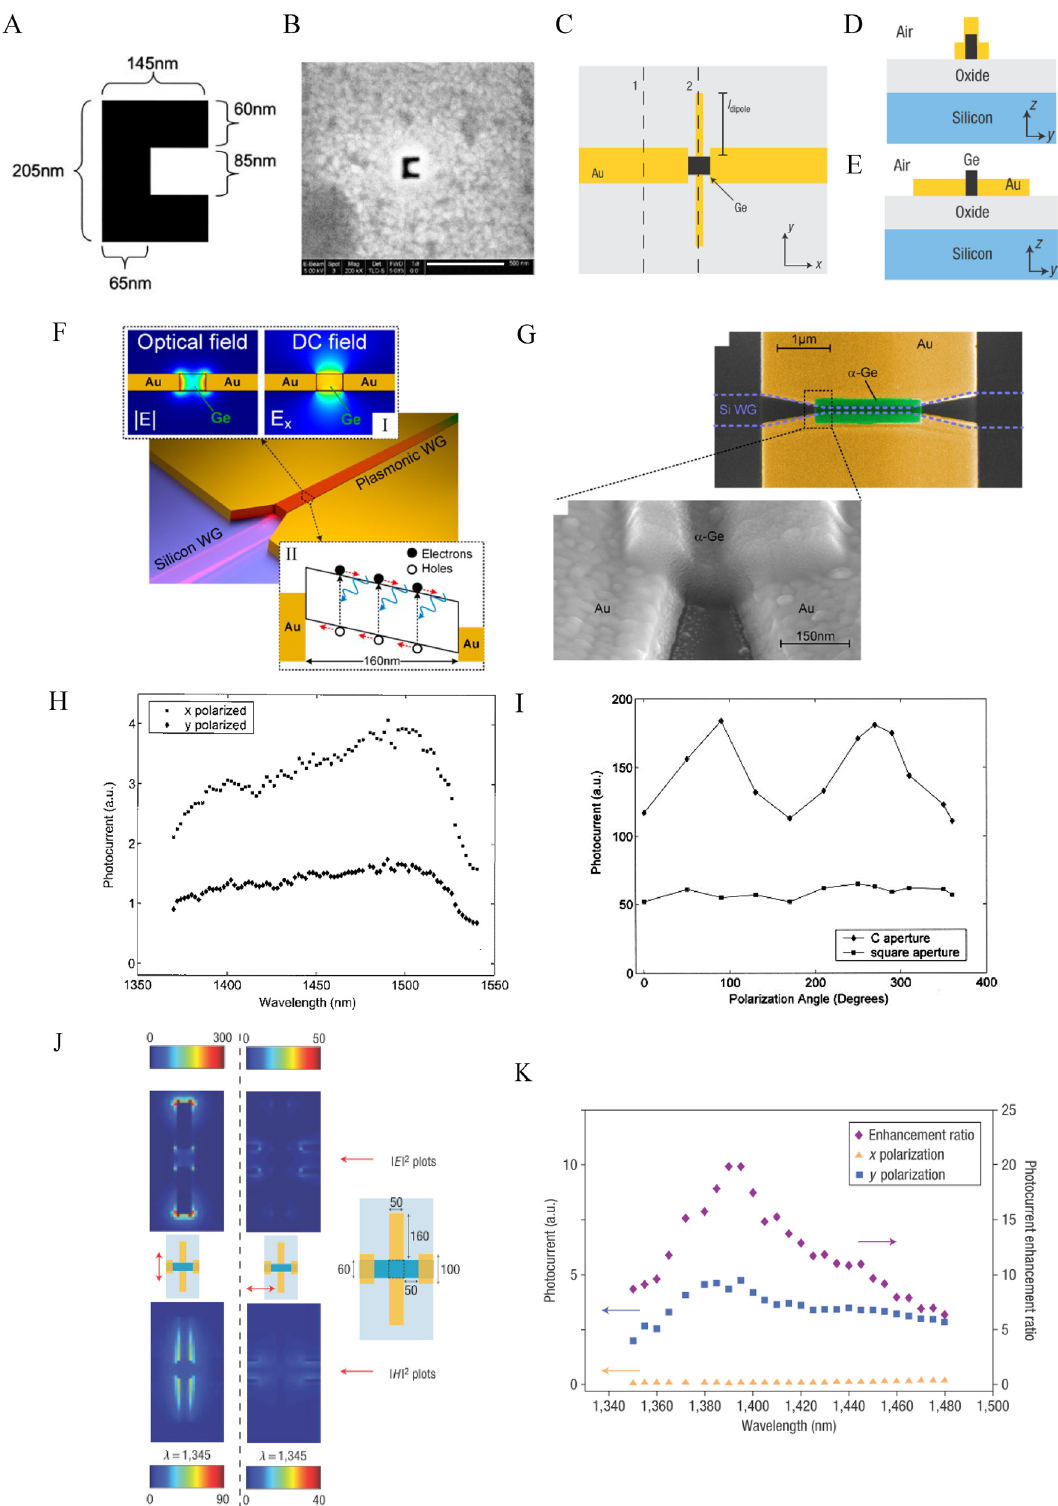
Figure 5: (A) Schematic illustration of the designed C-shaped nano-aperture with featured dimension of less than 100 nm. (B) Top-view SEM image of the C-shaped nano-aperture fabricated in Au film. The scale bar is 500 nm. Copyright 2006, Optical Society of America. (C) Top view and (D, E) cross-sectional views of schematic representations of Ge-based photodetector featuring open-sleeve dipole-type antenna. (D) and (E) are the cross-section view corresponding to line one and line 2, respectively, as indicated in (C). Copyright 2008, Springer Nature. (F) Schematic representation and (G) SEM images of plasmonic nanoslot waveguide photodetector. Inset I in (F): Simulated optical and